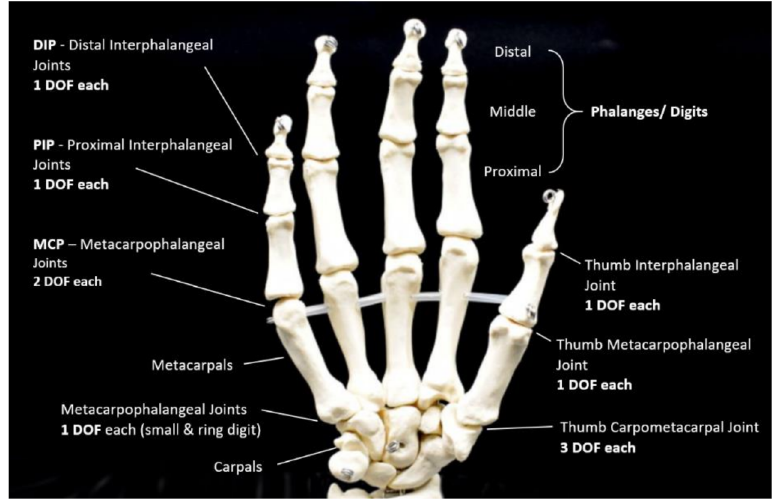
Figure 4. Degrees of freedom (DOF) of hand